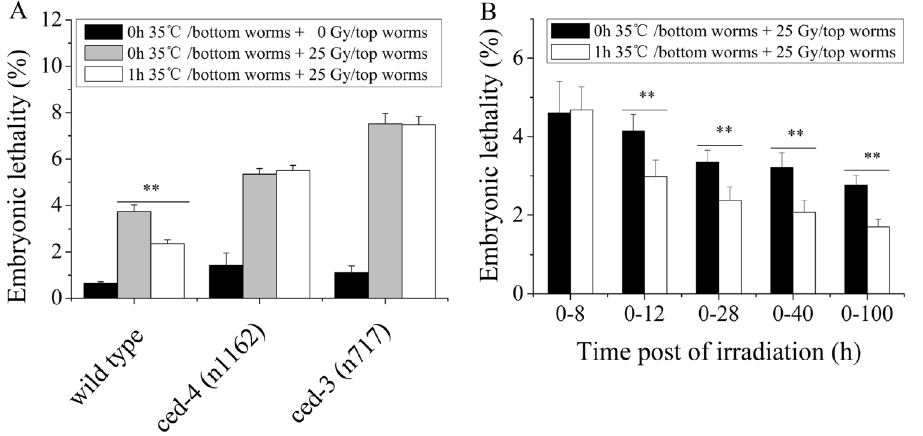
Figure 4. The heat-stress volatile signals mainly acts on the mitotic proliferating cell and meiosis cell of the gonads of top worms. ( A ) Embryonic lethality of the top worms whose apoptosis function is absent ( ced-3 and ced-4 ) after coculture with the heat-stressed worms (N2); ( B ) Embryonic lethality of the top worms at different time points following challenge irradiation after coculture with the heat-stressed worms. Results are means ± SD (n = 5, ** P <